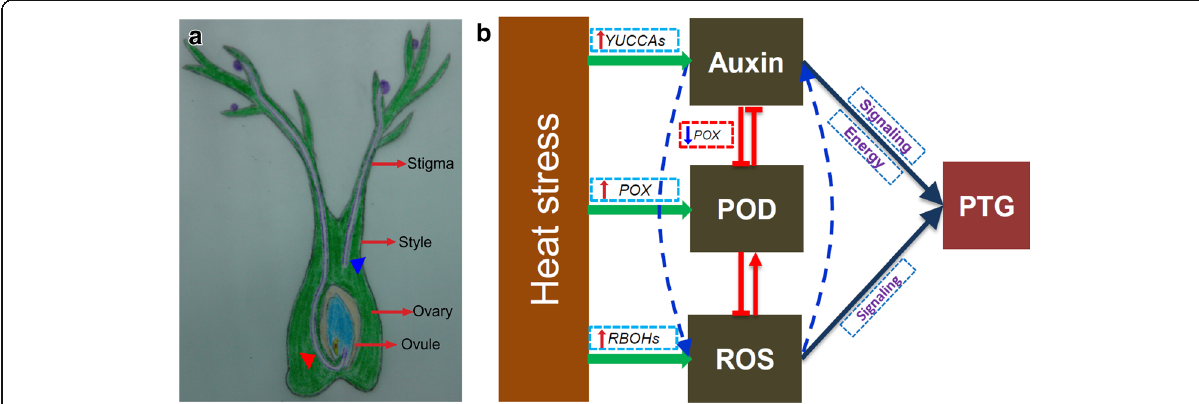
Fig. 6 Descriptive model of the function of auxin in the pollen tube growth in rice pistil. The level of auxin, ROS and POD in the pistil are obviously affected by heat stress, and thus the relationships among them are involved in the pollen tube elongation in the pistil. The triangle symbol indicates the pollen tube in the pistils, while the triangle in red indicates the pollen tube under natural conditions, and that the green triangle indicates the ceasing of pollen tube growth in the style under heat stress. PTG, denotes pollen tube growth. The pointed arrow indicates enhancement, while the blunt-ended arrow , indicates